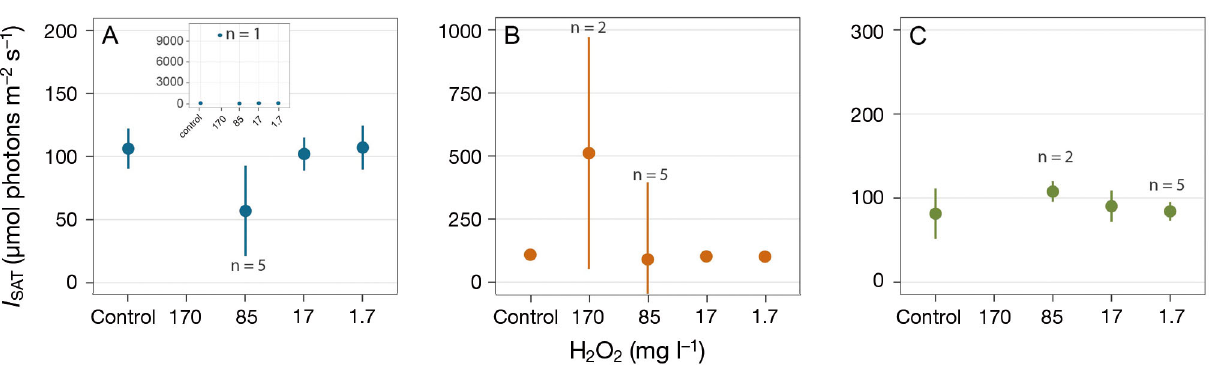
Fig. 5. Effect of 1 h exposure to 5 different concentrations of H 2 O 2 , including control, on the saturating irradiance ( I SAT ) of juve- nile Saccharina latissima plants. Median (±1 SD) response (A) immediately post-exposure (Day 0), (B) 24 h post-exposure (Day 1), and (C) 15 d post-exposure (n = 6 unless otherwise stated). Note different y -axis scales. Inset: zoomed-out view of plant I SAT